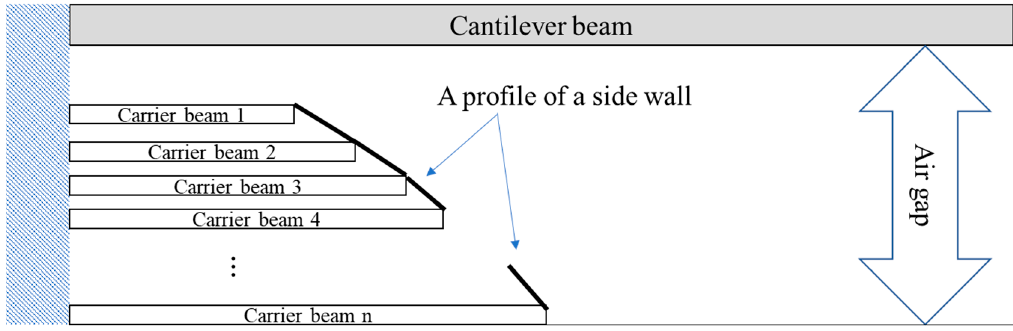
Figure 2. The assumed side